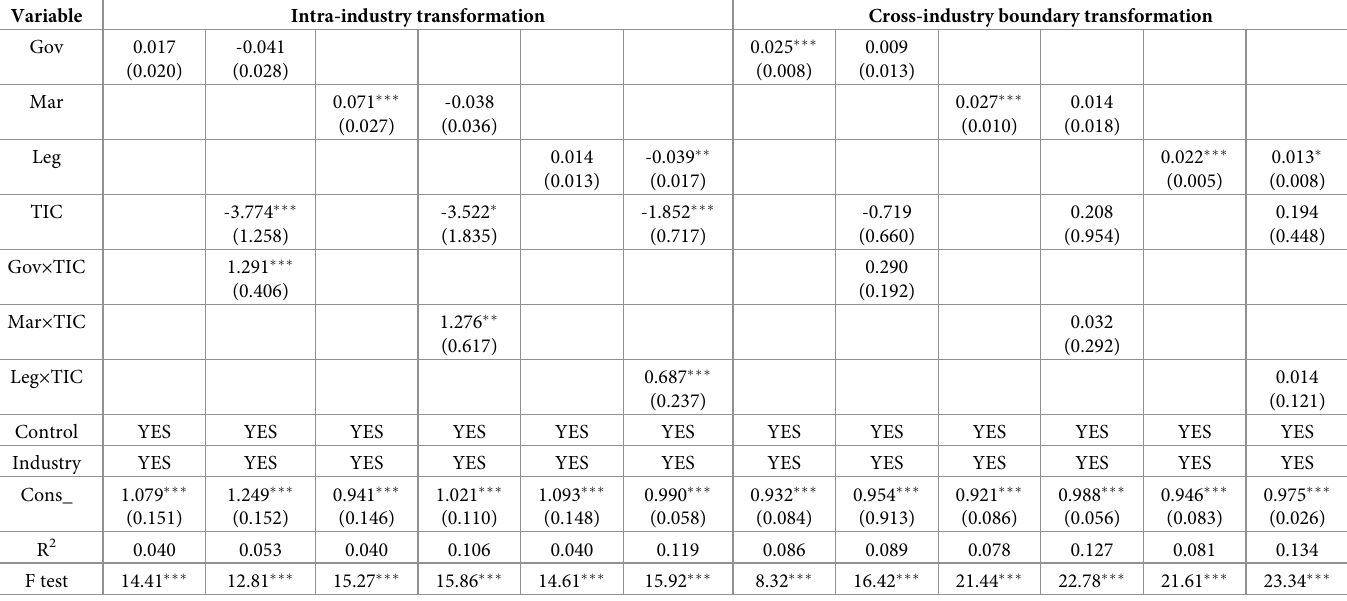
Table 6. Heterogeneity in the intra-industry transformation of different property enterprises.